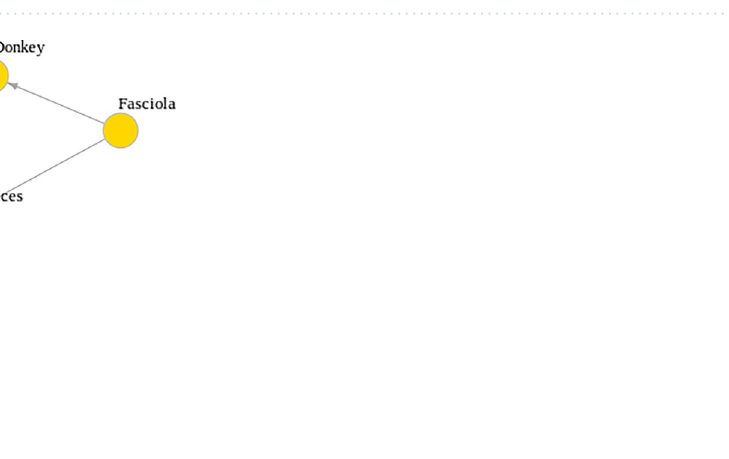
Figure 5. IGV view of damaged and total mapped reads of C. goldi : upper track is related to damaged reads. Damage is not presented in whole reads. Edited by Microsoft paint, version 21 H2, https:// www. micro soft. com/ en- us/ windo ws.